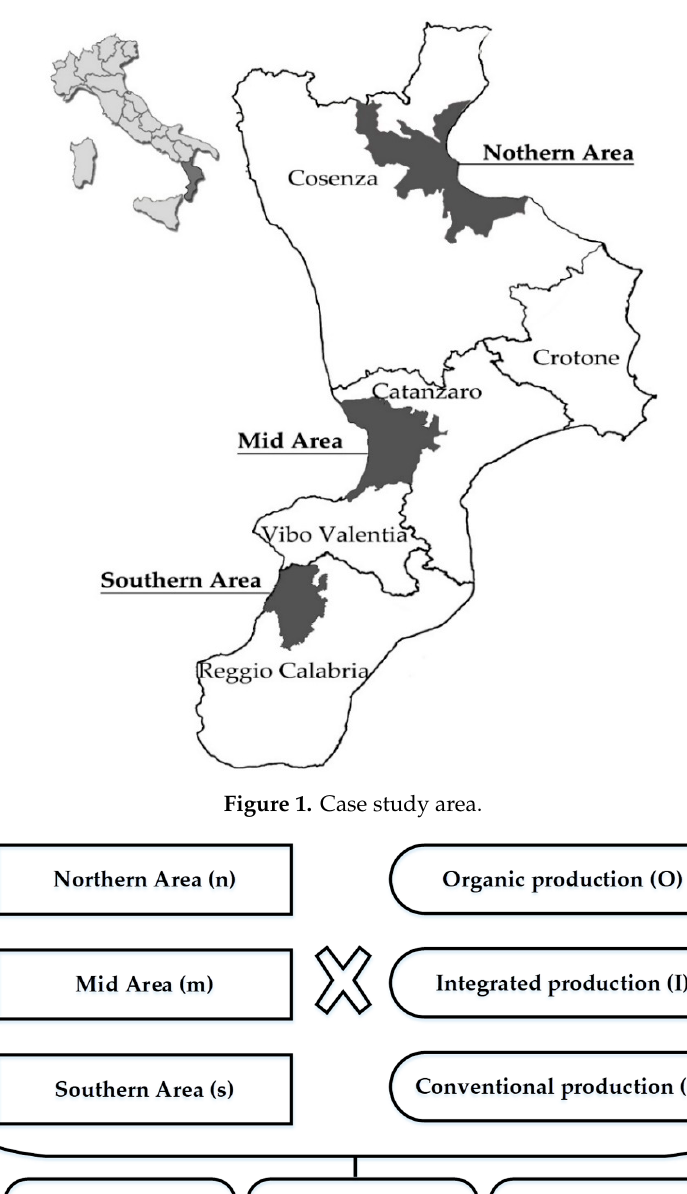
Figure 2. Scenarios synopsis .